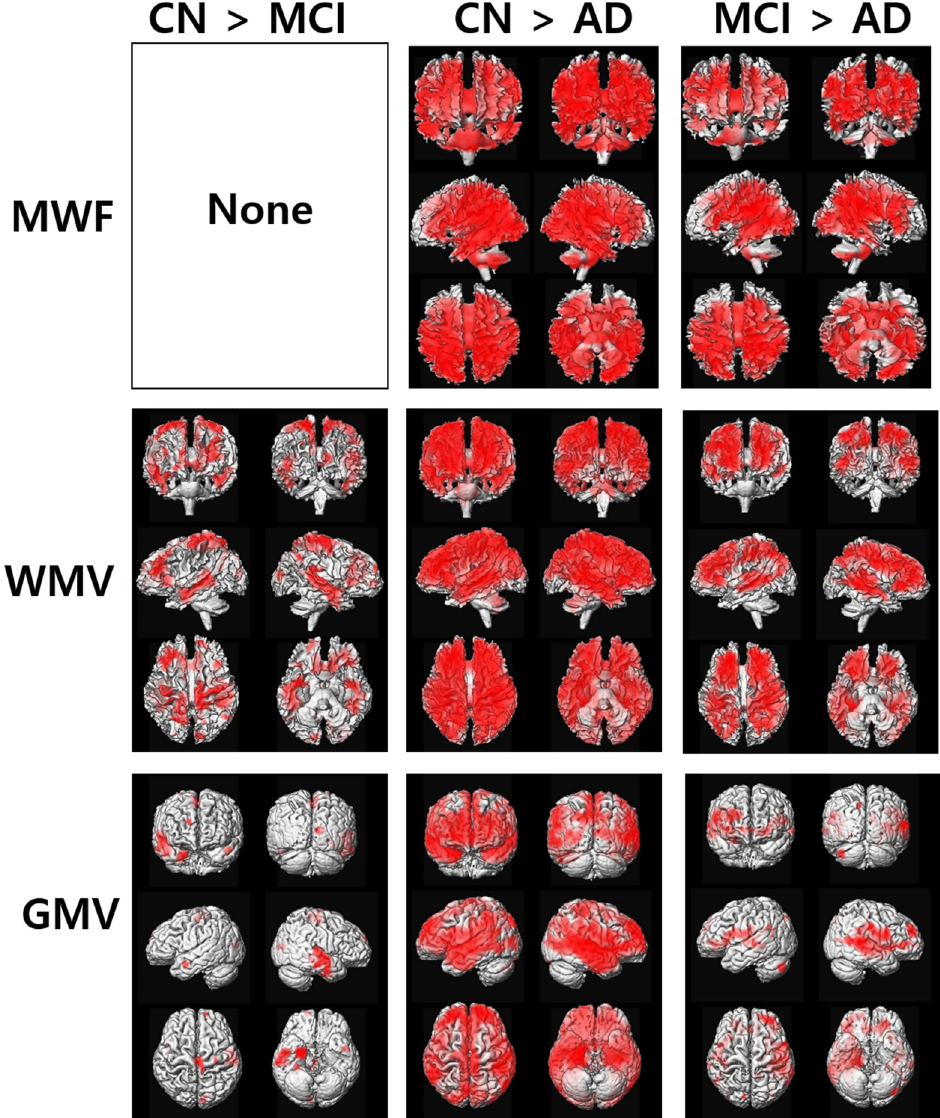
Figure 2. Results of voxel-based ANCOVA analysis of the maps of the apparent myelin water fraction (MWF), gray matter volume (GMV), and white matter volume (WMV) in the three participant groups of cognitively normal (CN) elderly individuals, participants with mild cognitive impairment (MCI), and patients with Alzheimer’s disease (AD).